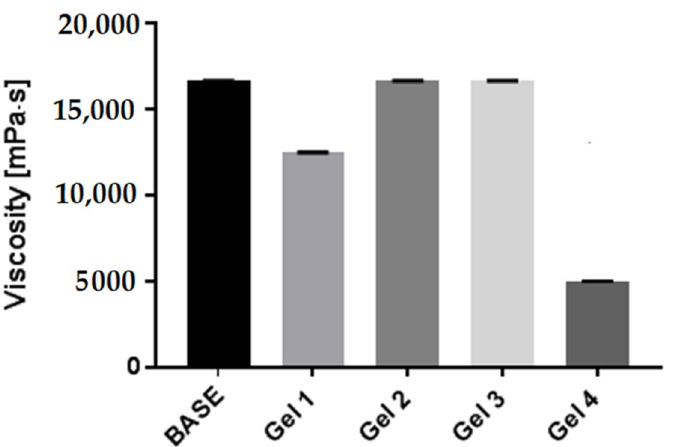
Figure 8. The viscosity of tested wash gel formulations containing aqueous Schisandra chinensis extracts was measured using a rheometer. Four types of aqueous extract (UAE-ultrasound-assisted extraction (Gel 1); MAE–microwave-assisted extraction (Gel 2); ME–maceration with continuous stirring (Gel 3); HAE–heat-assisted extraction (Gel4)) of Schisandra chinensis fruits are used. Values are the mean of six replicate determinations ( n = 6).